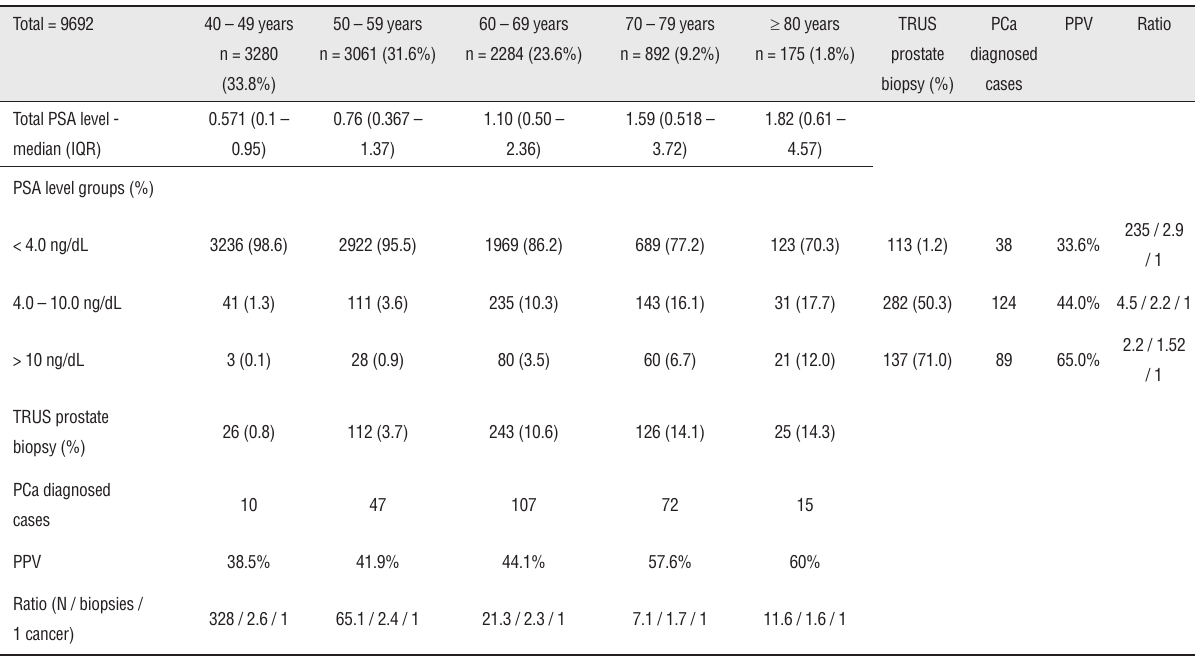
Table 1 - Distribution of the screened patients stratified according to the age groups and PSA levels.